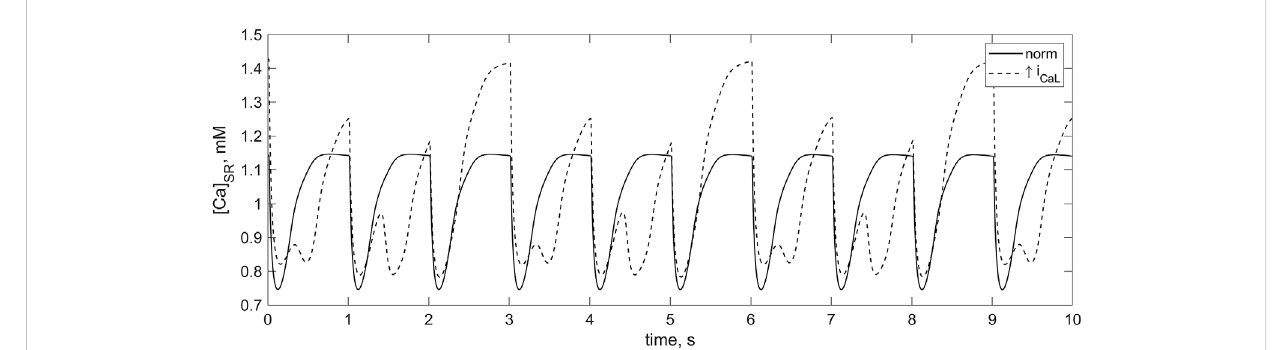
FIGURE 11 Calcium SR concentration in the TP + M model shown for 10 s. There is 1 Hz cardiomyocyte stimulation at normal i CaL conductance (solid line) and at twofold increasein i